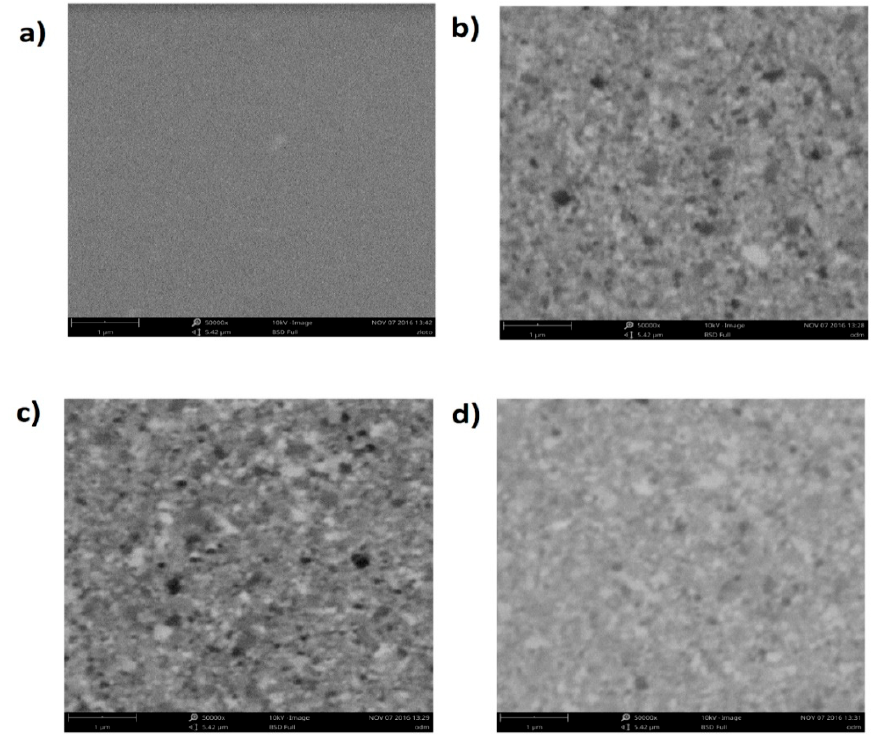
Figure 7. Scanning electron microscopy (SEM) images of the individual layers on the gold chip surface, ( a ) the bare gold; ( b ) 1-octadecanothiol (ODM); ( c ) cathepsin L inhibitor (RKLLW-NH 2 ). ( d ) Cathepsin L (CTSL).